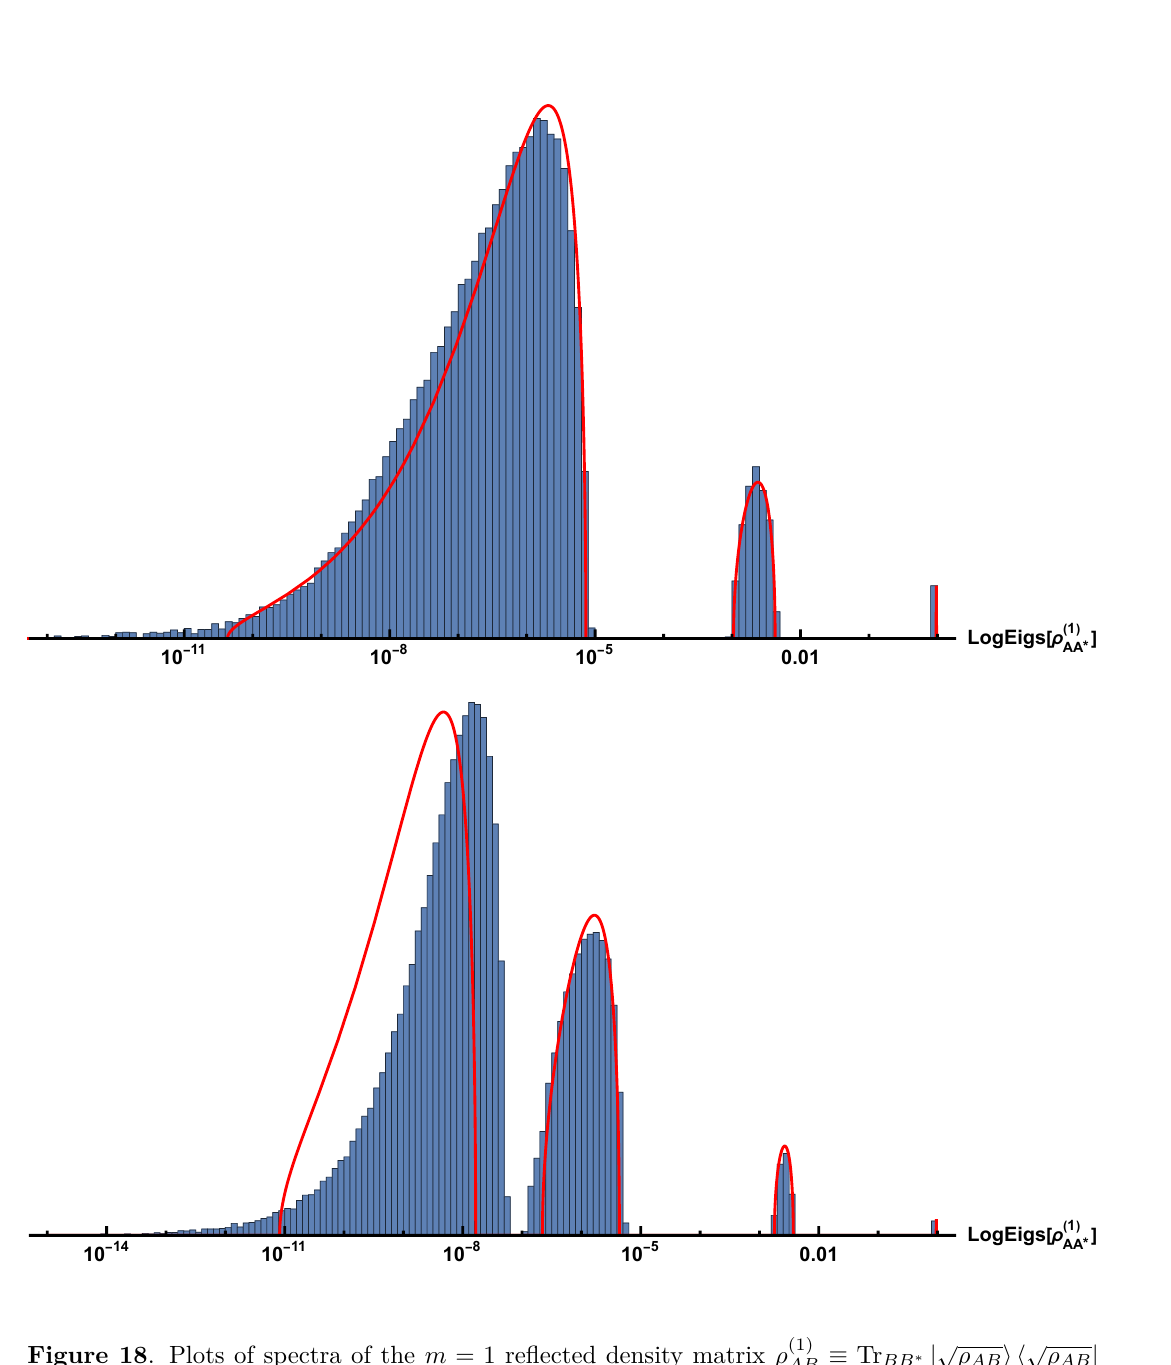
Figure 18 . Plots of spectra of the m = 1 reflected density matrix ρ (1) for { χ = { 16 , 16 , 40 , 40 , 4 } (top) and { 30 , 30 , 70 , 70 , 4 } (bottom). The analytic A , χ B , χ C 1 , χ C 2 , χ } predictions are shown as red lines. The mismatch of the k = 3 peak in the bottom plot is due to the fact that we can only work numerically in low bond dimension. As we scale up the bond dimensions in numerics, the agreement becomes better. We expect that it can also be resolved by improving the analytics, including subleading corrections to the eigenvalues beyond first